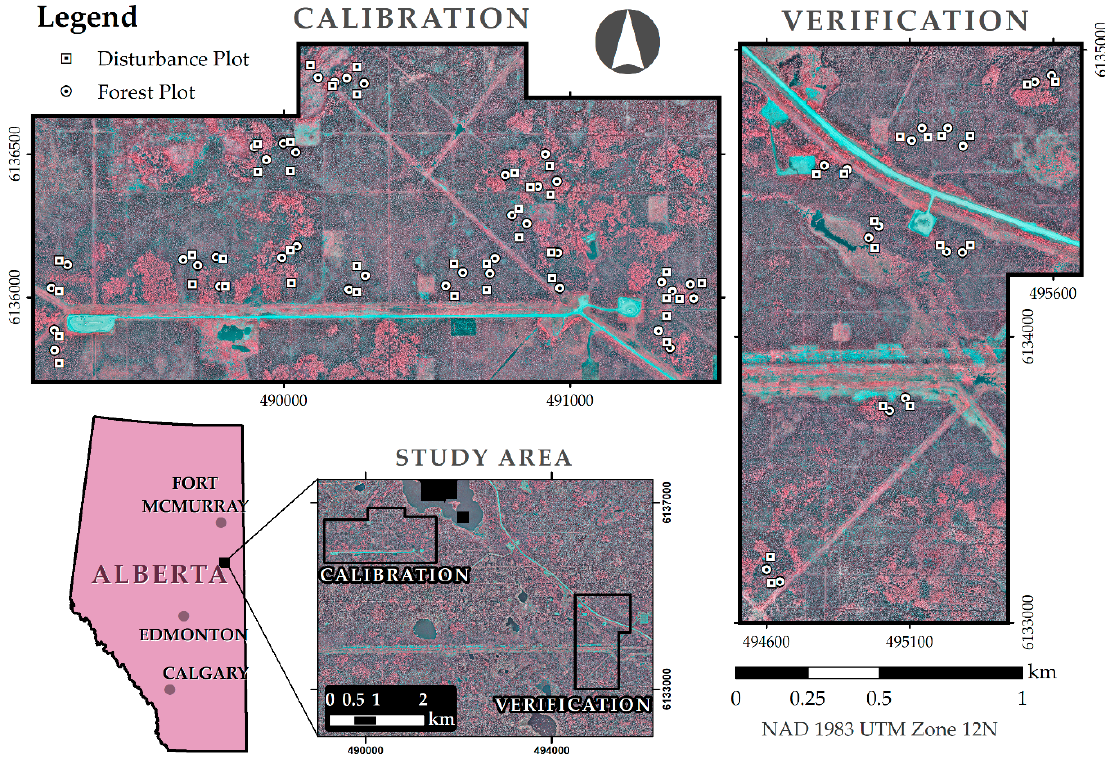
Figure 2. Location of the calibration and verification areas within the 4300-hectare study area as well as the location of the field plots where CWD volume was surveyed. The background image is a false-color image using near infrared, red and green spectral bands. Upland broadleaf stands dominated by trembling aspen appear as lighter shades of red; conifer-dominated lowlands and mixed-wood uplands appear as darker tones. Roads, seismic lines (petroleum-exploration corridors), and petroleum well pads appear as lines and geometric features.